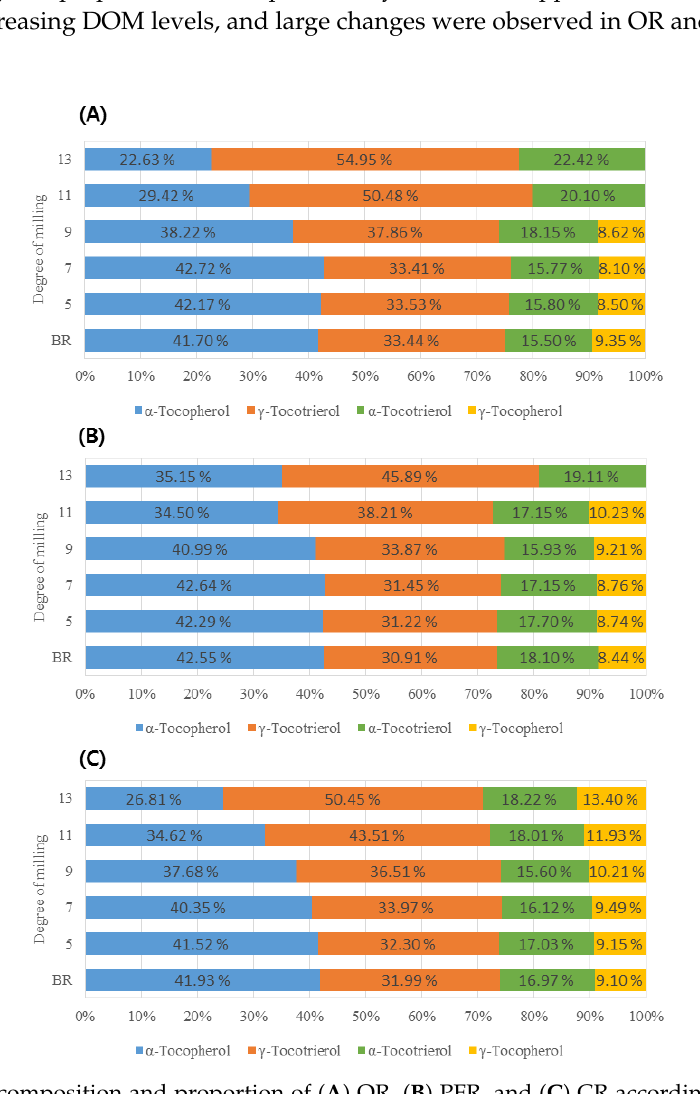
Figure 6. VitE composition and proportion of ( A ) OR, ( B ) PFR, and ( C ) CR according to the DOM. The percentage of each vitamin E indicates the ratio of the content of each vitamin E to the total vitamin E content.